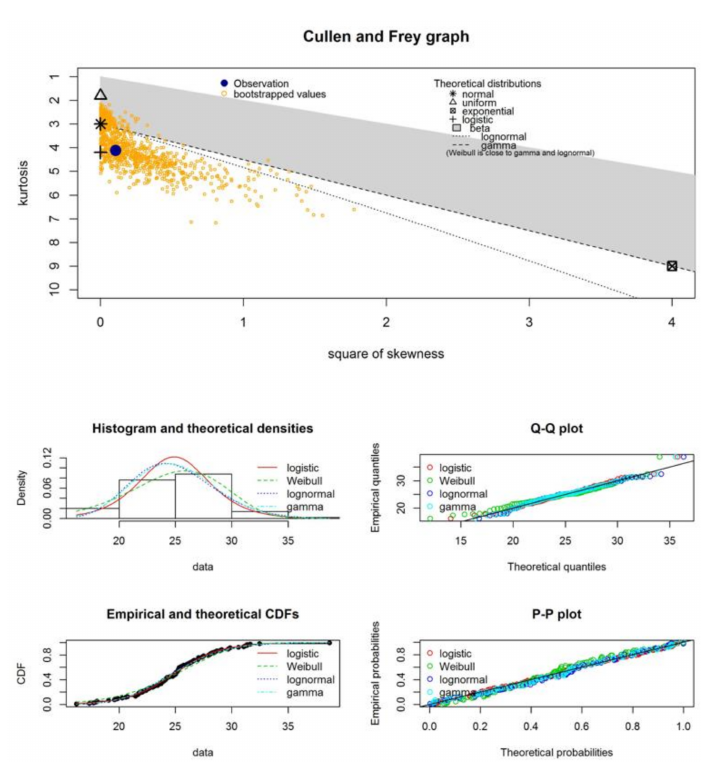
Figure A1. Statistical evaluation of nonwoven samples at the initial state: ( Top ) Cullen and Frey graph, and ( Bottom ) Probability density plot, cumulative distribution function, Q–Q plot, and P–P plot.